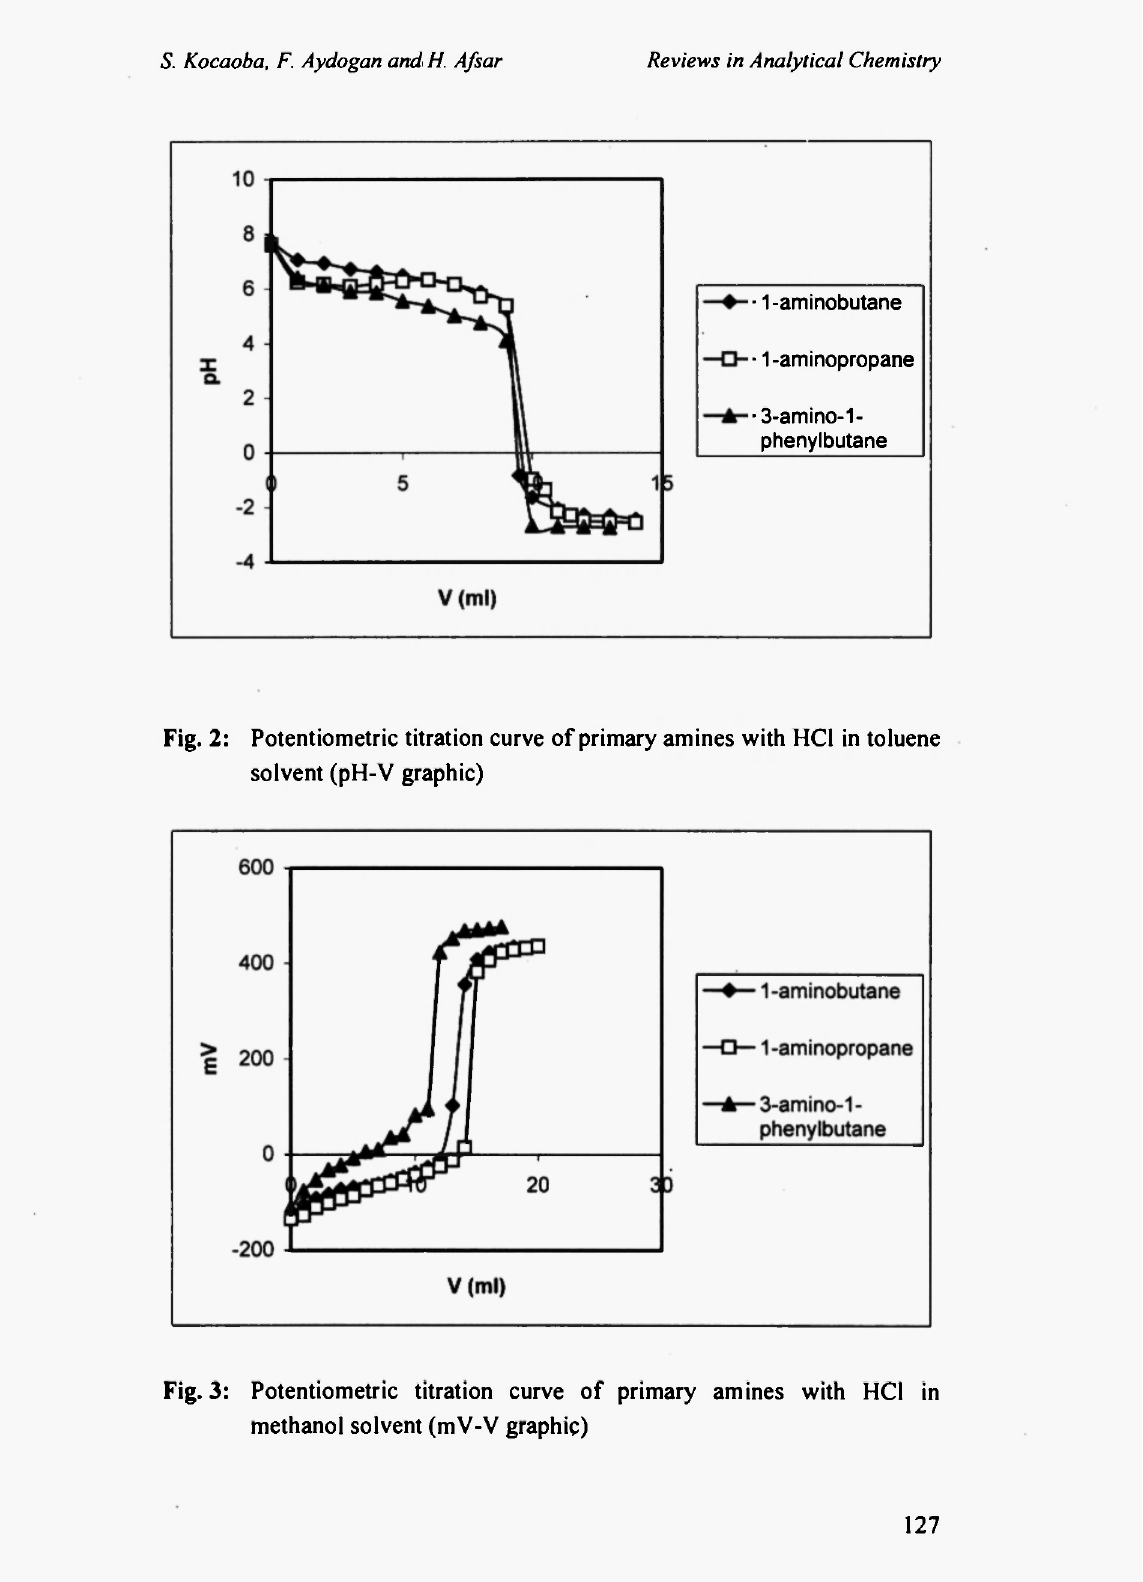
Fig. 3: Potentiometrie titration curve of primary amines with HCl in methanol solvent (mV-V